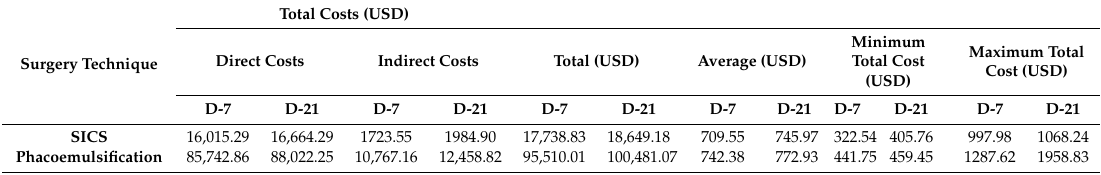
Table 3. Total Cost of Cataract Surgery Per Capita at Day 7 (D-7) and Day 21 (D-21).